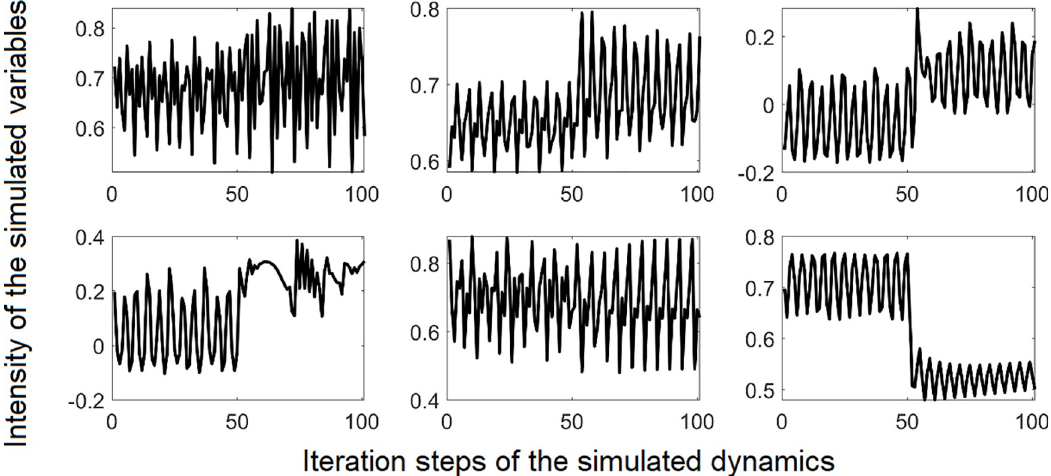
Fig 1. Exemplary time series with pattern transitions that were produced by a model of psychotherapeutic change. The simulated time series were used to optimize and validate the PTDA. Some transitions are characterized by a change of the mean, some by a change of the variance, and others by a change of different features in the domain of frequency or complexity. X-axis: 100 iterations of the simulation runs, corresponding to the segment between iteration 100 and 200 as shown in Fig 2A, lower part. Y- axis: Intensities of the simulated dynamics. The range of the variables produced by the theoretical computational model is [-1, +1] for E, P, S and [0, +1] for I and M. https://doi.org/10.1371/journal.pone.0265335.g001 value between 0 and 1 with upper and lower limits of [0, 1] for the final parameters and a mini- mum change of +/- 0.05. Each simulation produces 5 time series (one for each of the five vari- ables of the model). The first 100 data points of each time series were discarded to account for saturation effects (transient period); the TP was thus located at T = 150 (Fig 2). 100 out of the resulting 300 data points were used depending on where on the time series the TP was evalu- ated. For example, the interval [100, 200] was used to simulate a transition in the middle of the time series ( T = 50) (Fig 2A), the interval [70, 170] to simulate a transition at the end of the